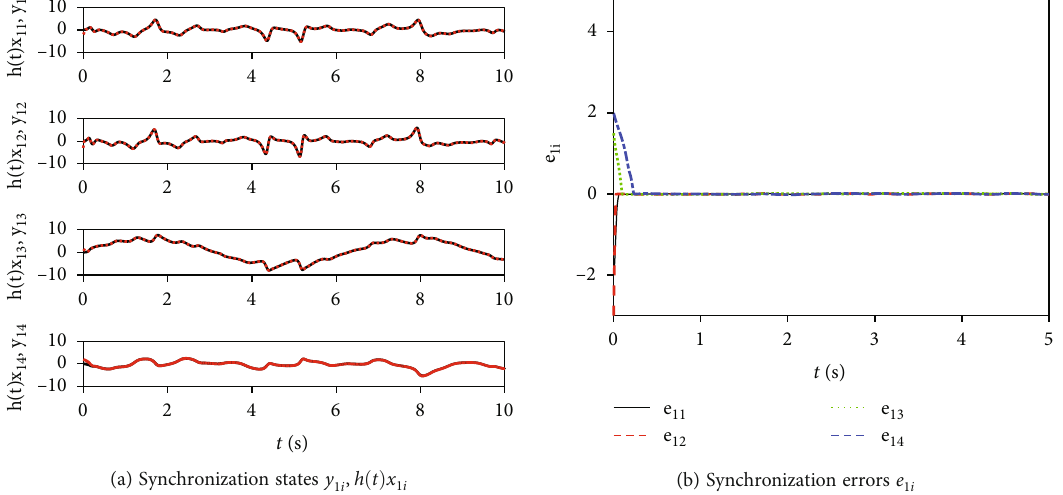
Figure 8: The time evolution of synchronization between y